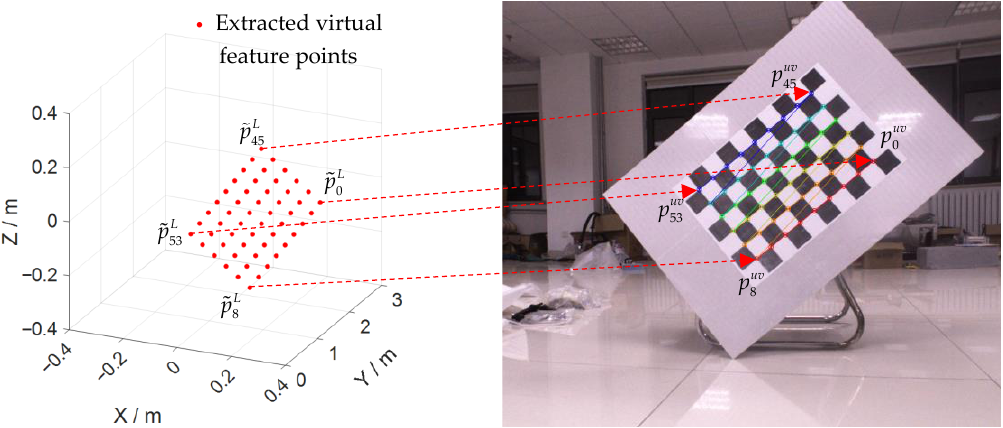
Figure 9. Correspondence between spatial corner points and pixel corner points.